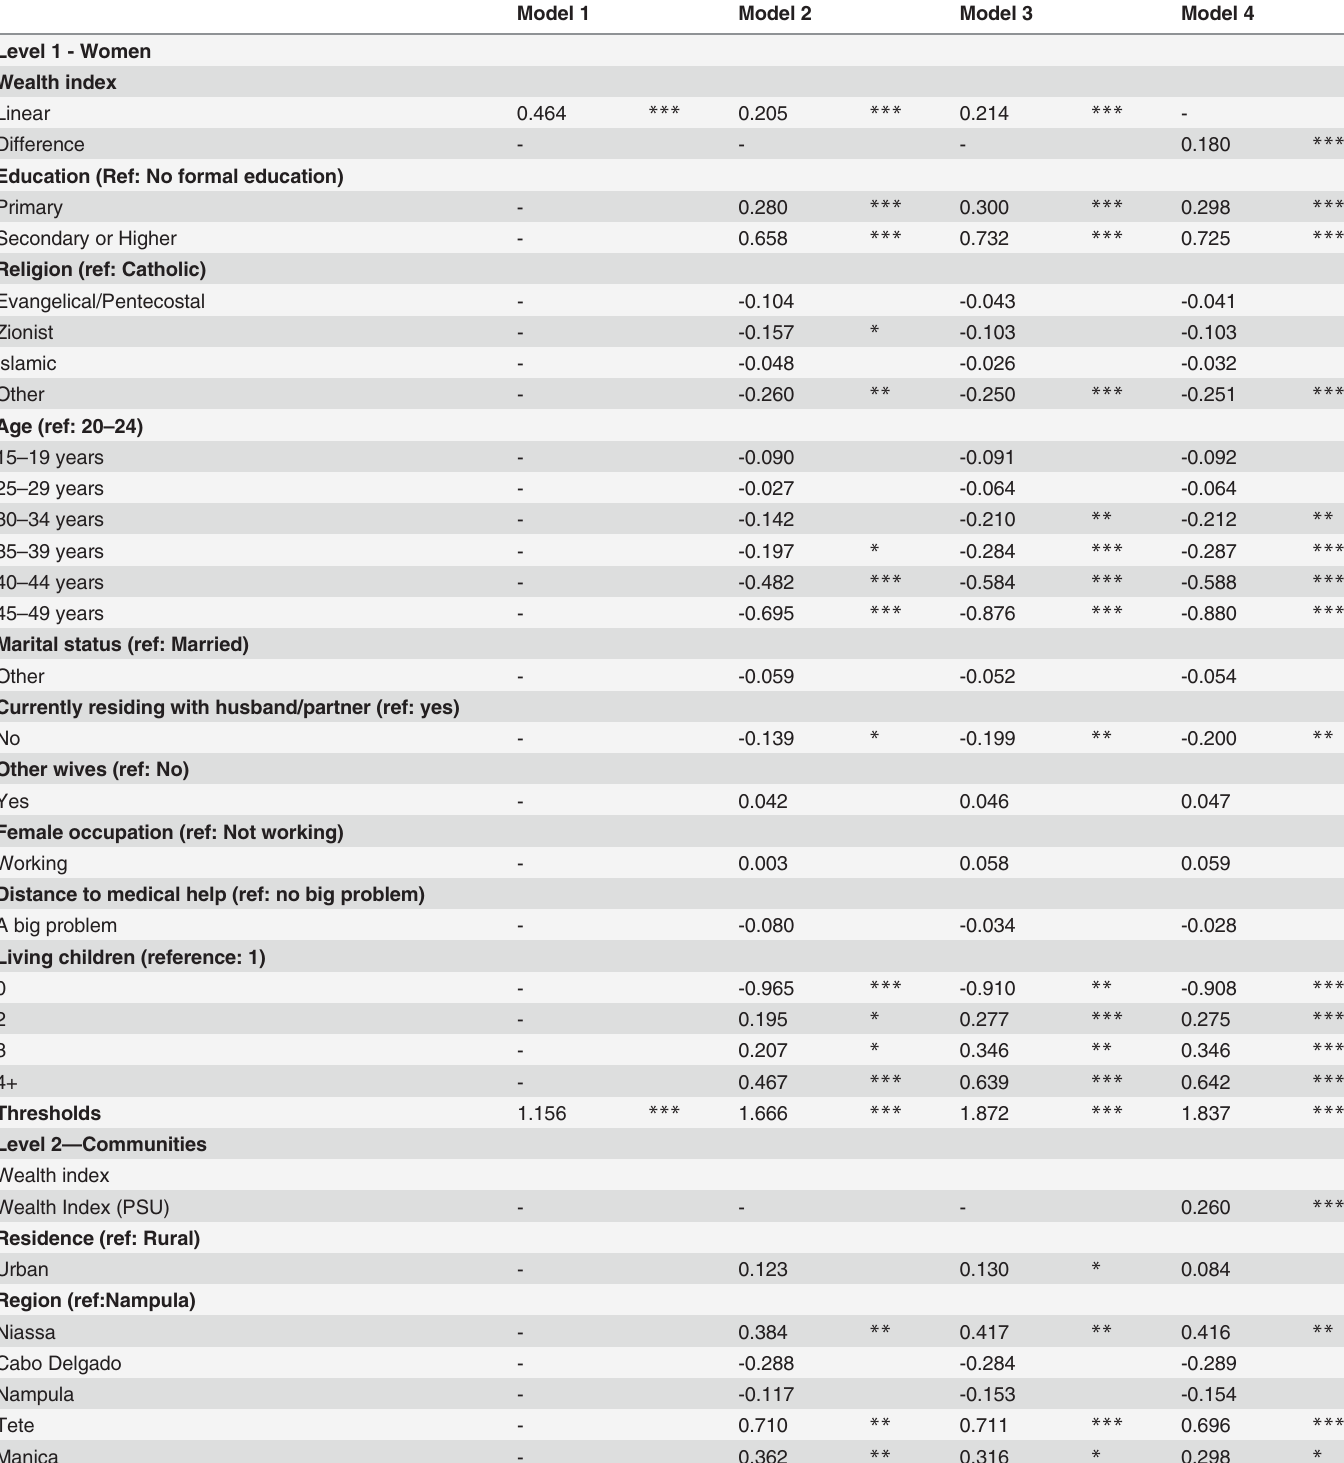
Table 2. Probit regression models for contraceptive use (ref: